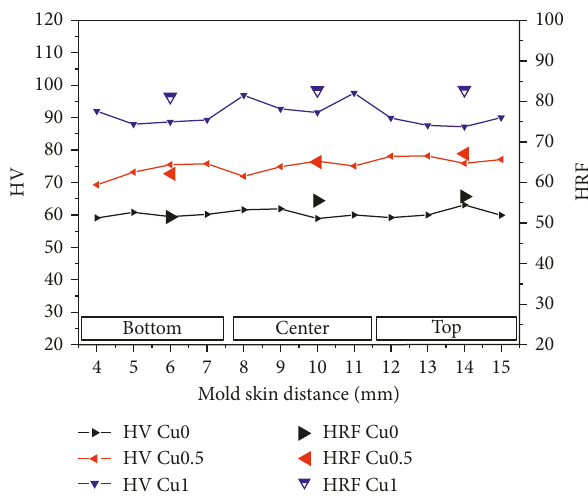
Figure 4: Cast ingot hardness profile. Vickers microhardness scale on the left; Rockwell hardness scale on the